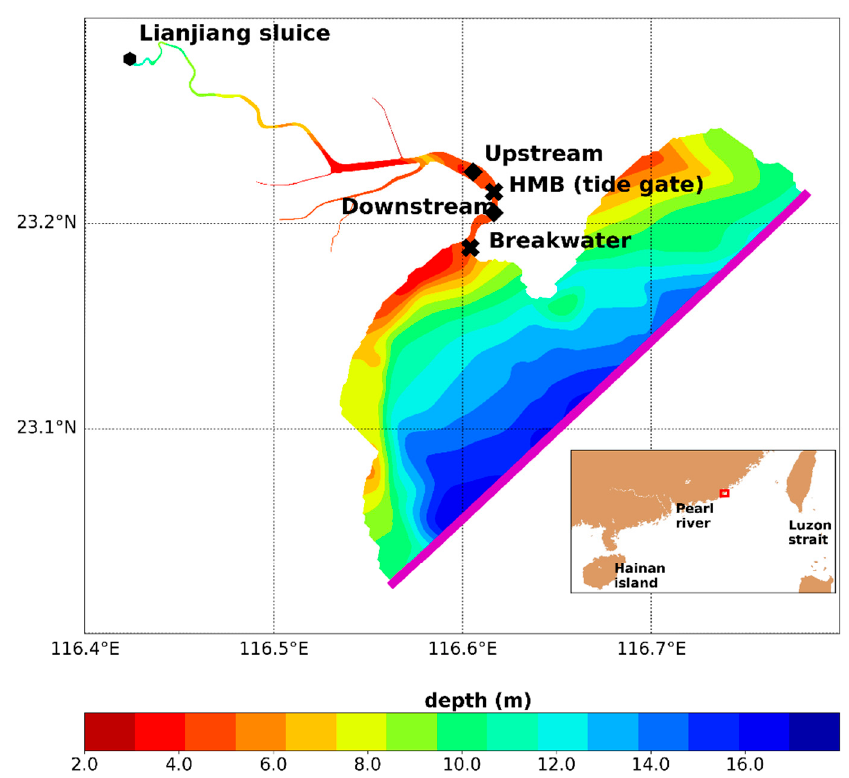
Figure 1. Bathymetry of the simulation domain. Cross-sections used for time series analysis are marked out by black diamonds and for flux calculations by black crosses. Open boundaries of upper and lower limits are depicted by a black dot and a magenta line, respectively. The inset shows the northern part of the South China Sea and the Lianjiang Basin which is enclosed by the red rectangle.